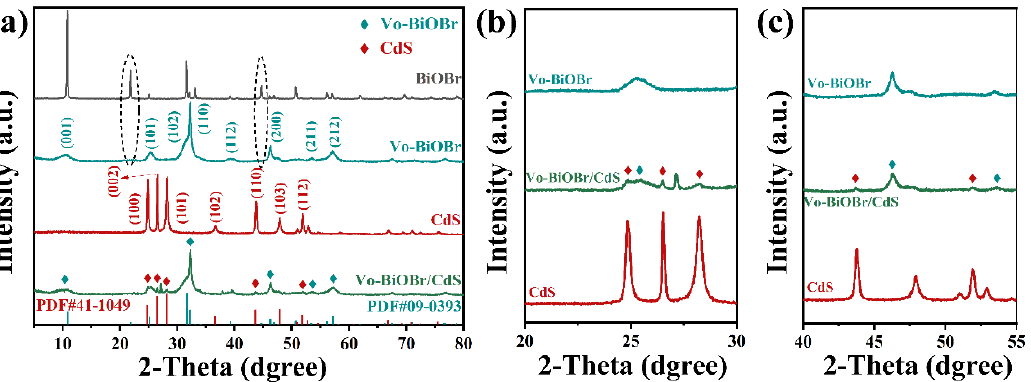
Figure 2. XRD patterns of Vo-BiOBr/CdS in different ranges of diffraction angle: ( a ) 5–80°, ( b ) 20–30°, ( c ) 40–55°.